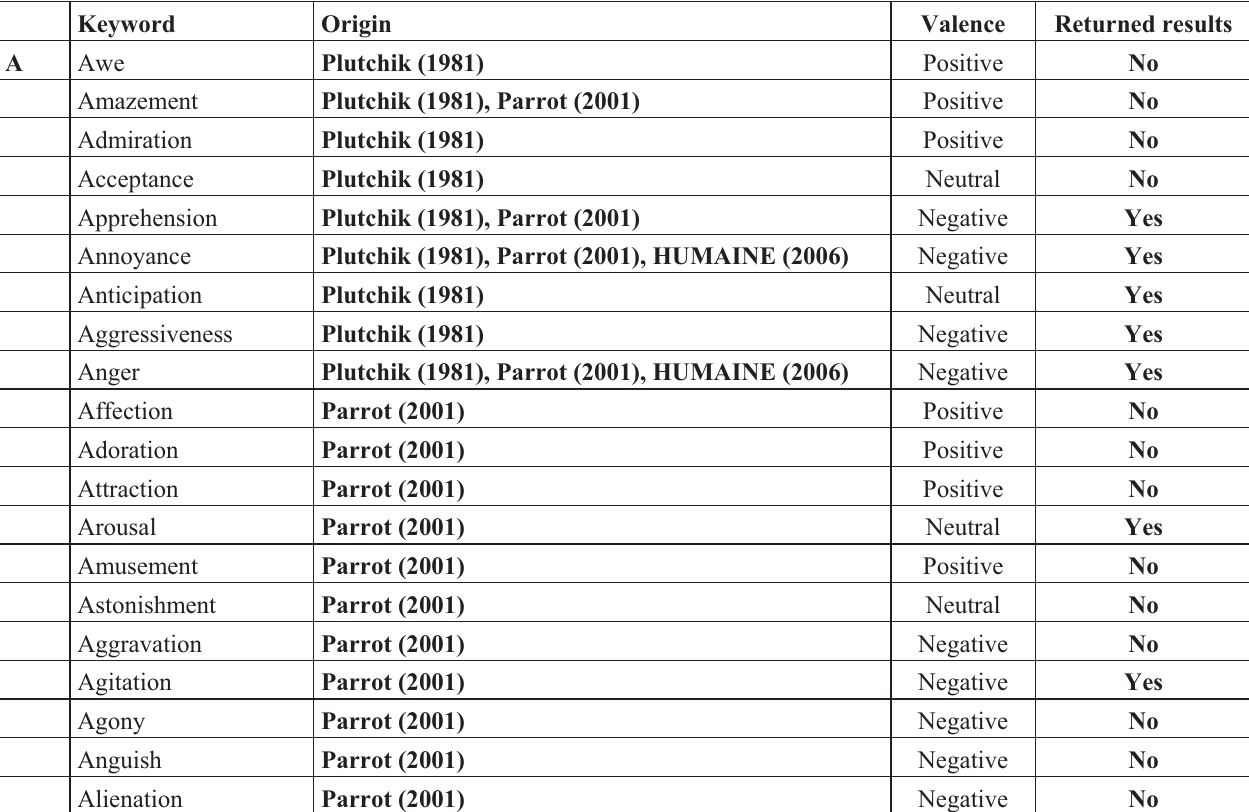
Table A1. The keywords used in the study, including details of their source, valence and whether they returned suitable